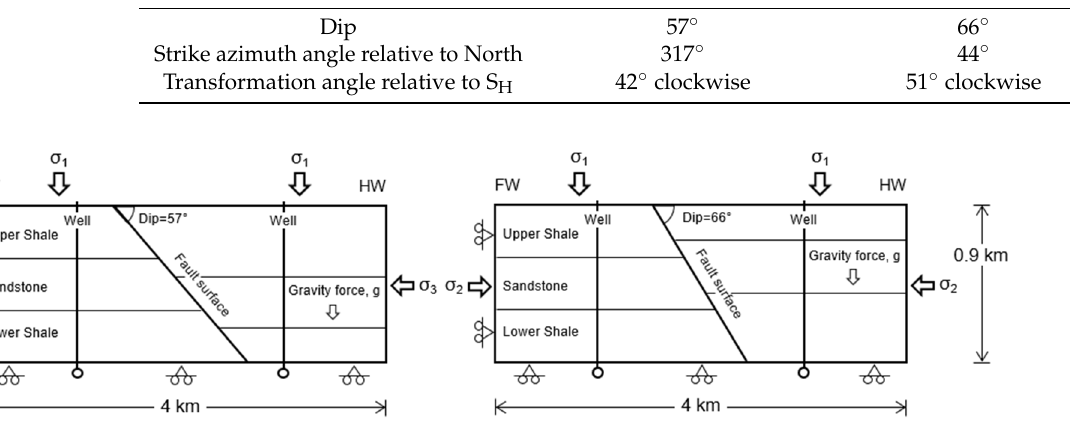
Figure 3. Geometry of the 2D fault models. Normal fault model on the left and reverse fault model on the right.